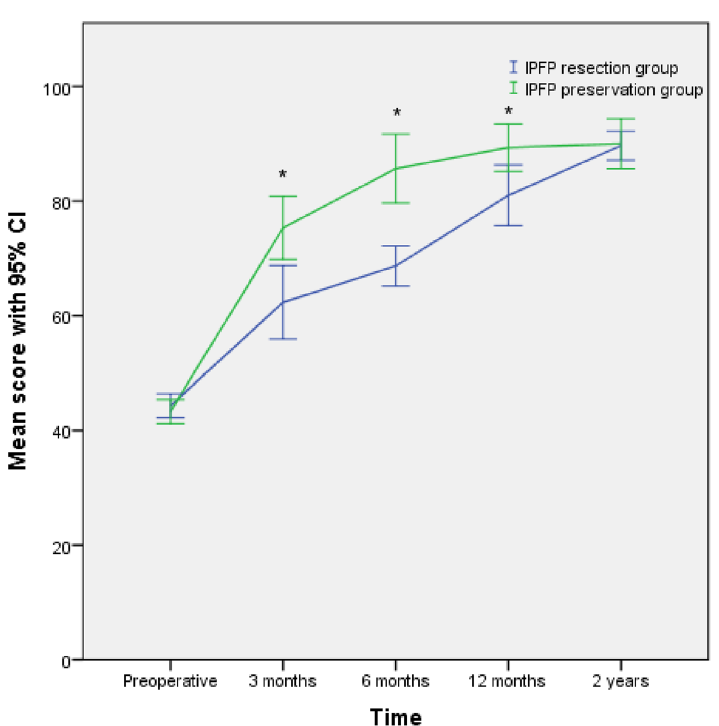
Figure 3. The mean overall Anterior Knee Pain Scale for both groups at different intervals with a 95% confidence interval (CI). *P < 0.05 between the 2 group scores at 3 months, 6 months, and 12 months postoperatively ( IPFP infrapatellar fat